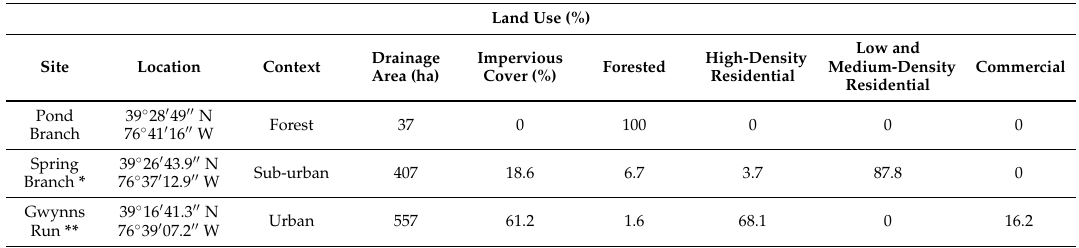
Table 1. Characteristics of Pond Branch, Spring Branch, and Gwynns Run